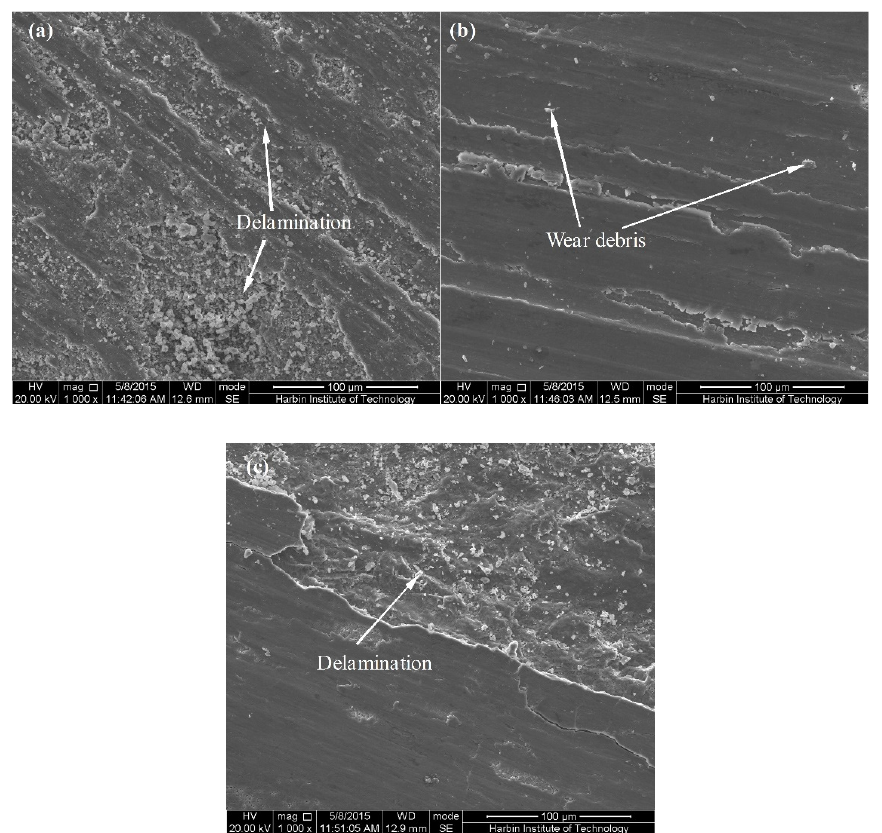
Figure 13. Friction coefficient, weight loss and wear rate of the thixoformed composite parts at different sliding velocities: ( a ) friction coefficient at 0.8 m/s, ( b ) friction coefficient at 1.2 m/s, ( c ) friction coefficient at 1.6 m/s, ( d ) average friction coefficient, ( e ) weight loss and ( f ) wear rate.